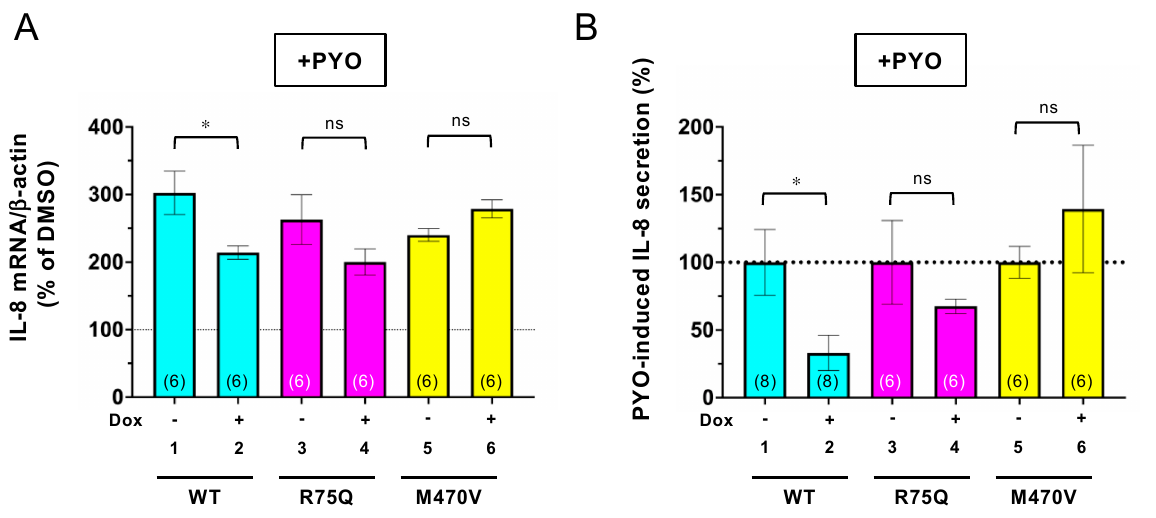
Figure 4. WT-CFTR, but neither R75Q nor M470V-CFTR, suppressed the PYO-induced IL-8 secretion in CFBE Tet-on cells. CFBE Tet-on cells expressing WT-, R75Q-, or M470V-CFTR were treated with or without Dox (1 µg/ml) for 3 days. PYO (5 µM) was treated for 24 hours before analysis. ( A ) PYO-induced IL-8 mRNA expression was quantified by RT-qPCR ( n = 6). ( B ) PYO-induced IL-8 secretion was analyzed by ELISA ( n = 6). Data represent mean±SE. n.s., not significant; * p < 0.05 ( t - test). The number of data from at least two independent experiments is indicated in parentheses.